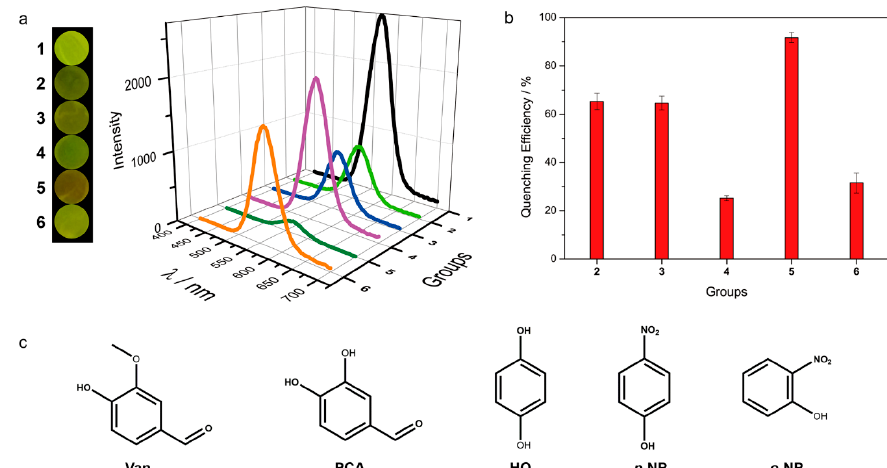
Figure 5. The interactions between the xerogel and various aromatic molecules. ( a ) The fluorescence spectra ( λ ex = 380 nm) of the xerogel after interacting with PBS ( 1 , blank control, pH = 8.00), Van ( 2 ), PCA ( 3 ), HQ ( 4 ), p -NP ( 5 ) and o -NP ( 6 ); ( b ) The calculated quenching efficiency and ( c ) chemical structures of the detected aromatic molecules.